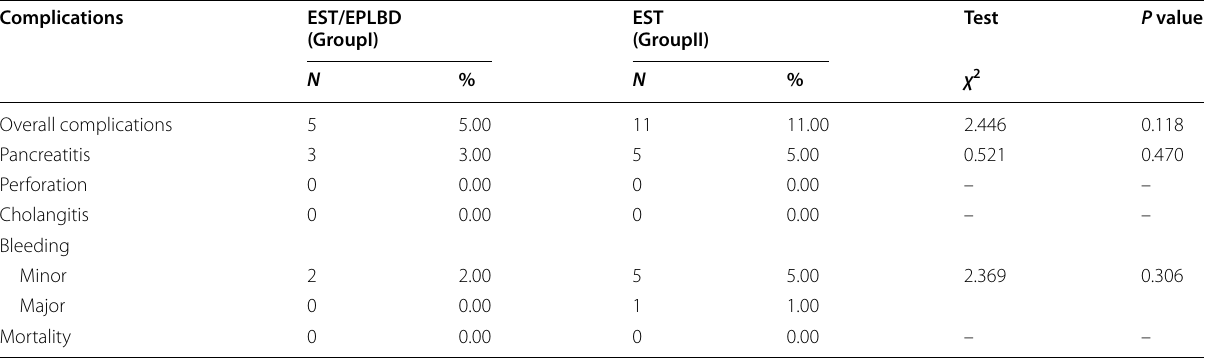
χ 2 chi-square, SD standard